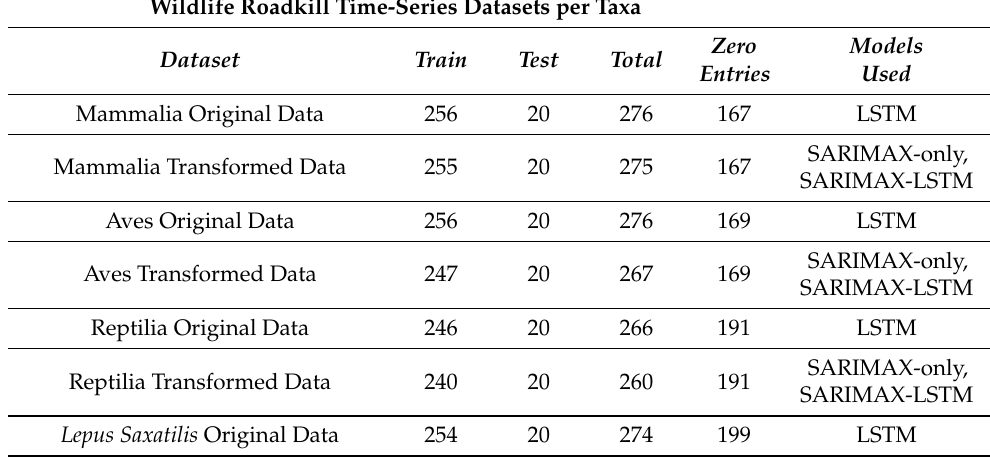
Table 5. Wildlife roadkill time-series data used by each model; SARIMAX is differenced to obtain a stationary dataset and LSTM is differenced with a shift of one for supervised